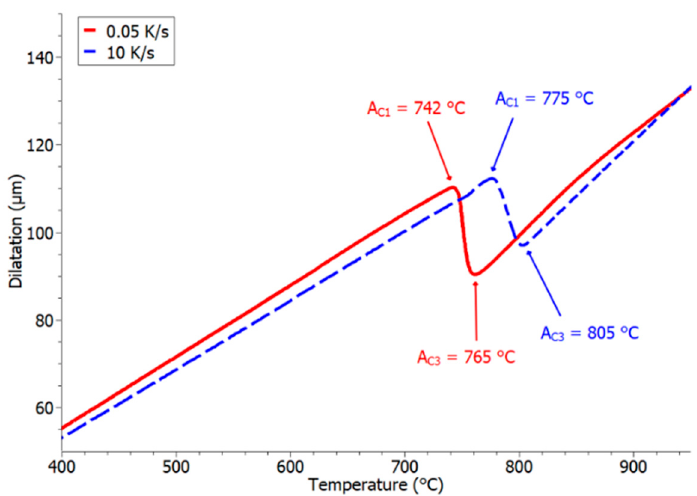
Figure 3. Determination of transformation temperatures at different heating rates.